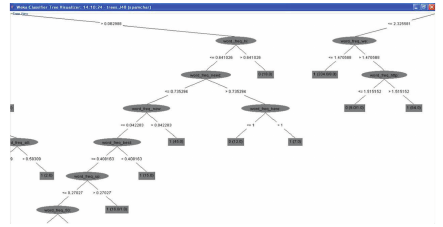
Figure 2: Tree of C4.5 classification result.